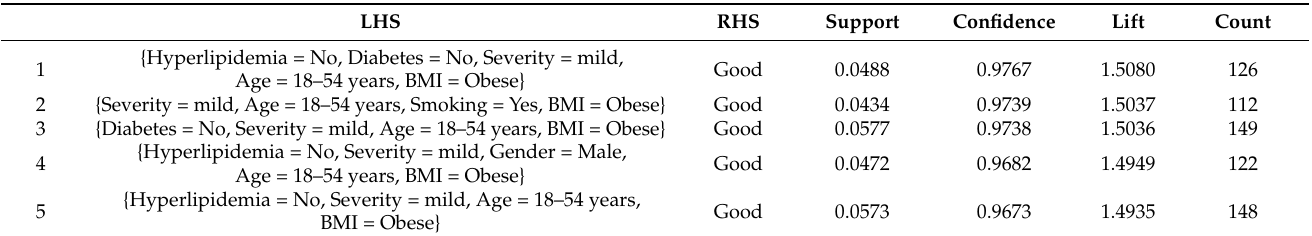
Table 6. Results of the frequent pattern growth algorithm of independent and dependent variables in patients with acute ischemic